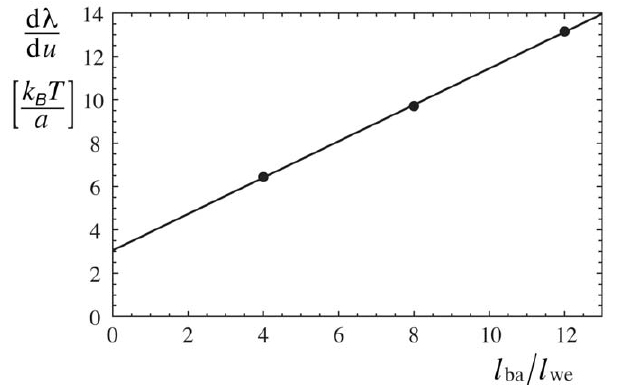
Figure 8. Critical radius r c for the nucleation of a microdomain of short R 1 L 1 complexes within a large domain of long R 2 L 2 complexes, as a function of the difference u 1 { u 2 between the rescaled effective binding energies of the domains (see eq. (26)). We have assumed here the values l we ^ 1 nm and l ba ^ 25 nm for the width and separation of the two wells in the effective potential. The critical radius decreases with u 1 { u 2 for constant value of u 2 , and decreases with u 2 for constant u 1 { u 2 .